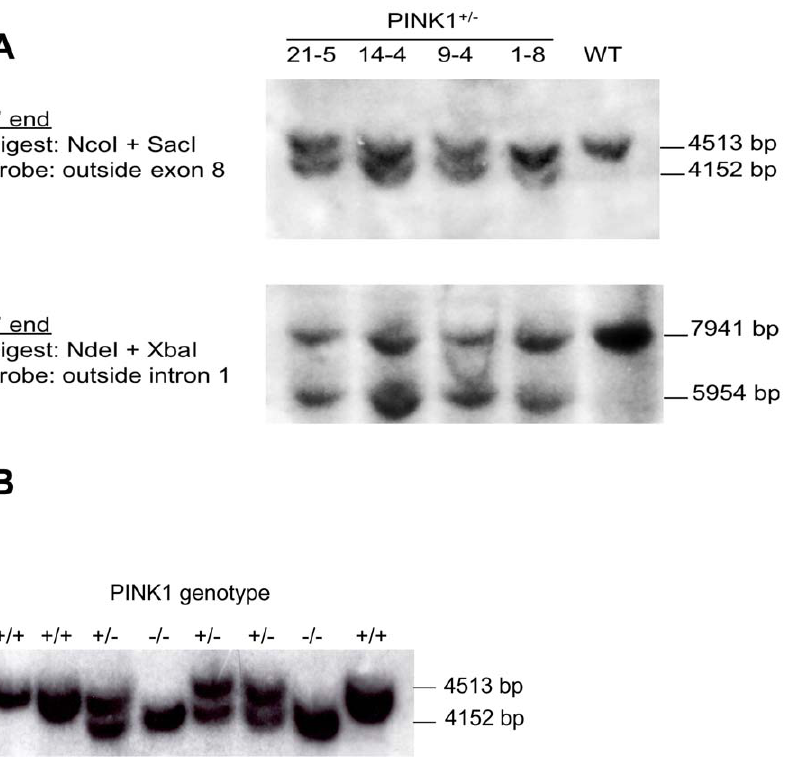
Figure 2. Southern blot analysis of ES cell colonies and F2 generation mice. (A) Genomic DNA from PCR-positive ES cell clones was double- digested with NcoI/SacI or NdeI/XbaI and hybridized with the indicated probes. The location of the two probes and expected sizes of the various DNA fragments for wildtype (WT) and Pink1 + / 2 ES cells are shown in Figure 1. (B) Tail DNA from offspring of Pink1 + / 2 breeder pairs was digested with NcoI and SacI and analyzed by Southern blot using ‘‘outside exon 8’’ probe. The 4513 bp band indicates the wildtype Pink1 allele and the 4152 bp band is diagnostic for the mutated Pink1 allele. Location of the probe and restriction enzyme cleavage sites are shown in Figure 1.